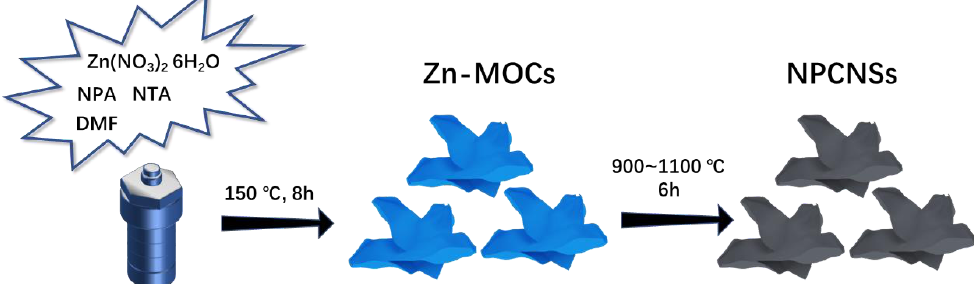
Figure 1. Schematic illustration for the fabrication process of